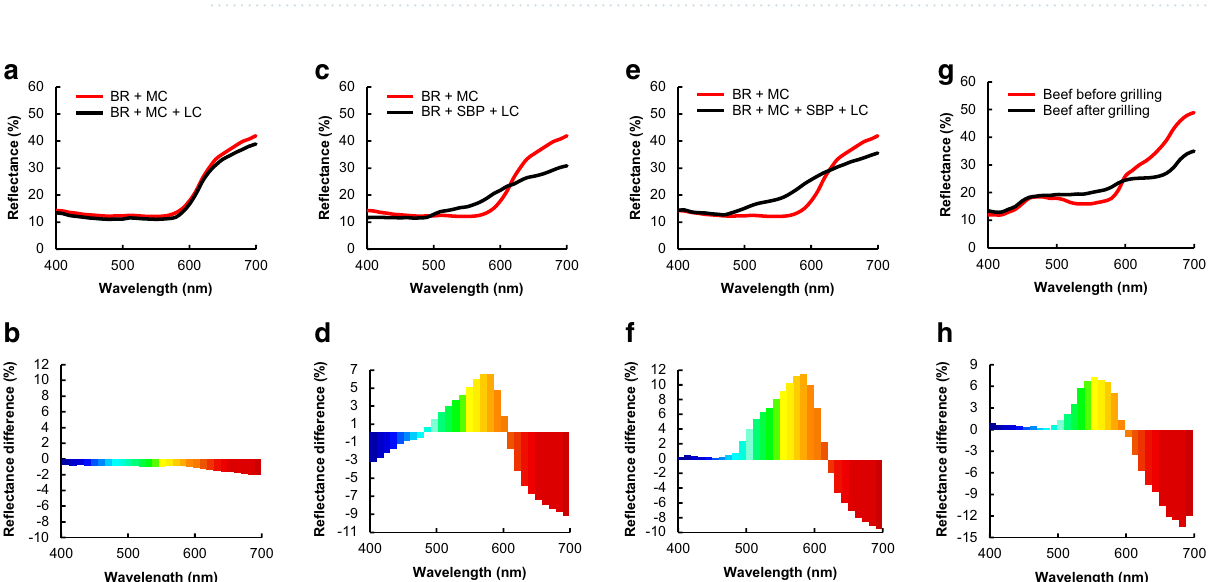
Figure 1. The appearance of the outside and inside of the meat analog patties before and after the grilling process.